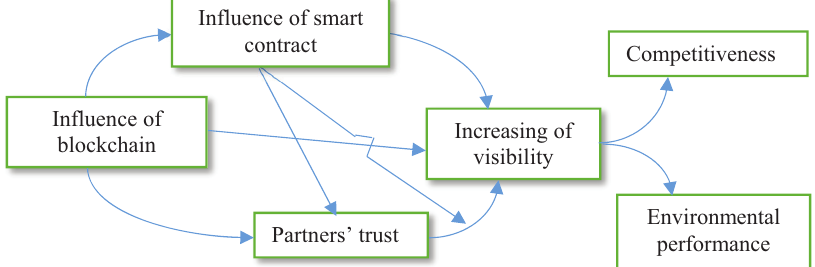
Figure 1. Research theoretical